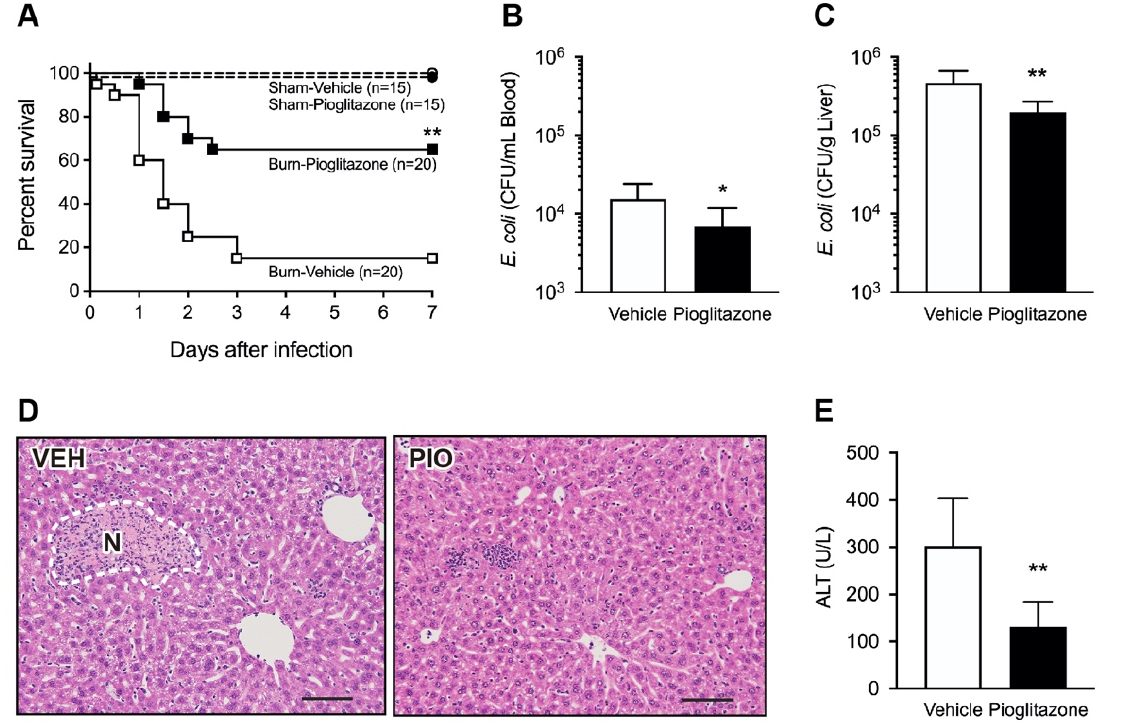
Figure 1. Pioglitazone improves bacterial clearance and survival in post-burn Escherichia coli -infected mice. Mice were treated with pioglitazone or vehicle control intraperitoneally 3 h before bacterial challenge and five days after burn injury. ( A ) Survival of mice after intravenous infection with E. coli (5 × 10 8 CFU). Mice were monitored every 12 h for the first three days and then once per day until seven days after infection. Sham: n = 15 per group, Burn: n = 20 per group, vehicle- or pioglitazone-treated mice; pooled data of two independent experiments. ( B – E ) To determine systemic bacterial clearance, mice ( n = 8 per group) were intravenously injected with E. coli (1 × 10 8 CFU), and the blood and liver were harvested aseptically 24 h after infection. Bacterial numbers in the blood ( B ) and liver ( C ) of the vehicle or pioglitazone-treated mice. ( D ) Representative hematoxylin and eosin staining of liver tissues 24 h after infection (200× magnification). Dashed line indicates the border of altered tissue forming a focal necrotic area (N). Bars = 50 μ m. ( E ) Serum levels of alanine transaminase (ALT) 24 h after infection. CFU, colony forming unit. Data are presented as the mean ± standard deviation (SD); * p < 0.05; ** p < 0.01 vs. vehicle.